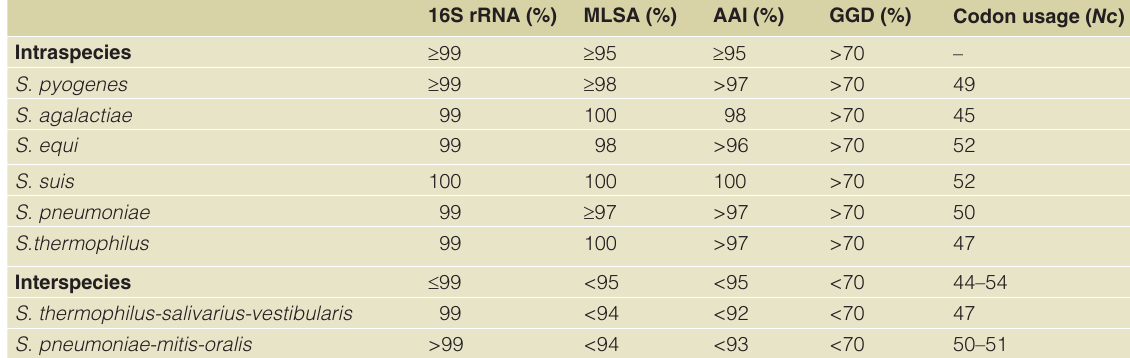
Table 2. Taxonomic resolution of genomic analyses of streptococci species. MLSA: multilocus sequence analysis. AAI: amino acid identity. GGD: genome to genome distance. Nc: effective number of